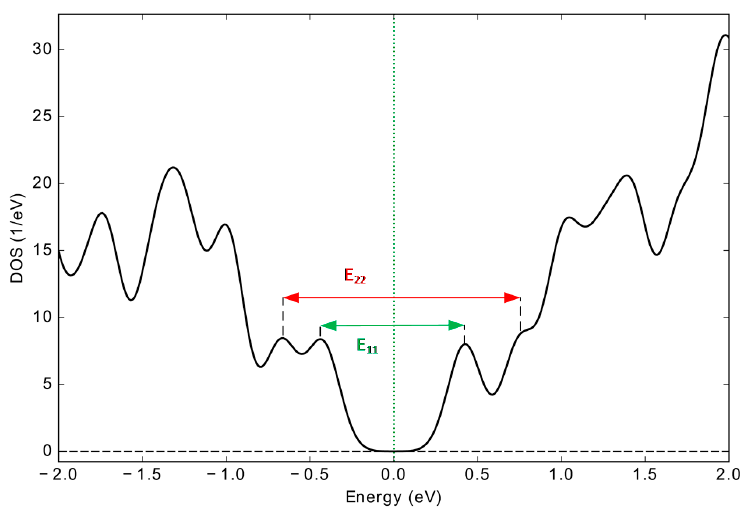
Figure 7. Projected density of states diagram (PDOS) of the bilayer ABhexC 132 H 40 GQDs, the E 11 ,